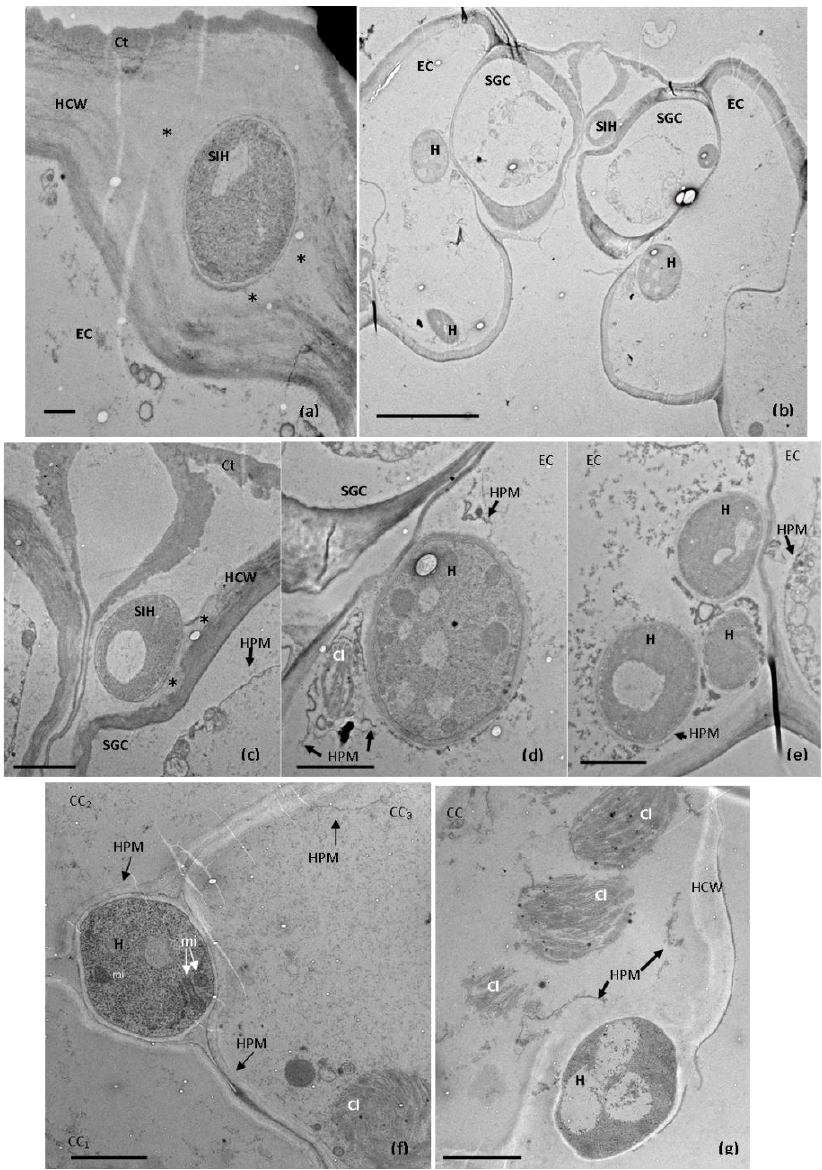
Figure 3. Electron micrographs showing colonization of Lupinus mutabilis petioles by Colletotrichum lupini 3 days after the inoculation. ( a ). A subcuticular intramural hypha (SIH) expanded between the cuticle (Ct) and the epidermal host cell wall (HCW). Degradation of the epidermal cell (EC) wall (asterisks) adjacent to the hypha is visible. Scale bar = 500 nm. ( b ). A subcuticular intramural hypha (SIH) near the wall of a stomatal guard cell (SGC) and intracellular hyphae (H) in epidermal adjacent cells (EC). Scale bar = 10 µm. ( c ). Enlargement of “b”, showing the degradation/dissolution of the wall (asterisks) of the stomatal guard cell (SGC) near the subcuticular intramural hypha (SIH). The plasma membrane of the stomatal guard cell apparently remained intact. Scale bar = 2 µm. HCW = host cell wall. ( d ). Enlargment of “b”, showing a hypha (H) within an epidermal cell (EC). The host plasma membrane (HPM) retracted away from the host cell wall, and it is possible to see